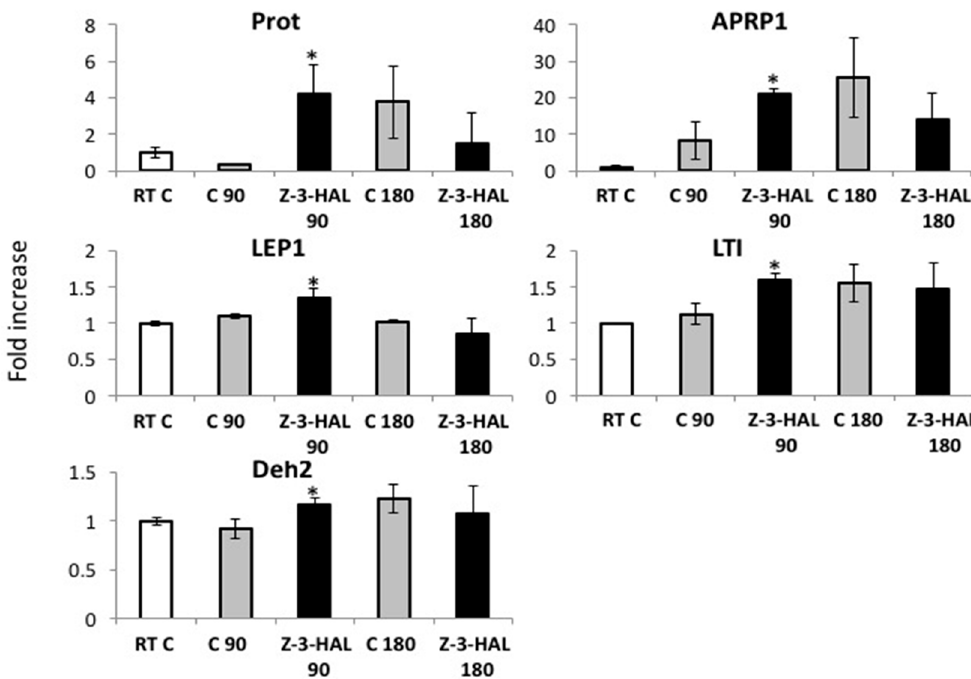
Figure 2. The effect of in-cold ( Z )-3-hexen-1-al (Z-3-HAL) treatment on cold stress related gene expression in maize ( Zea mays ) seedlings ( n = 3) under cold stress (5 °C). Seedlings were treated with physiological concentrations of Z-3-HAC (20 μ g l − 1 ) 30 min after being placed at 5 °C for 90 min and 180 min. Transcript levels were measured by RT-qPCR. The values are means ± standard error of the mean (SEM), and the asterisks indicate significant differences between the treated and untreated seedlings ( t -test, p < 0.05).